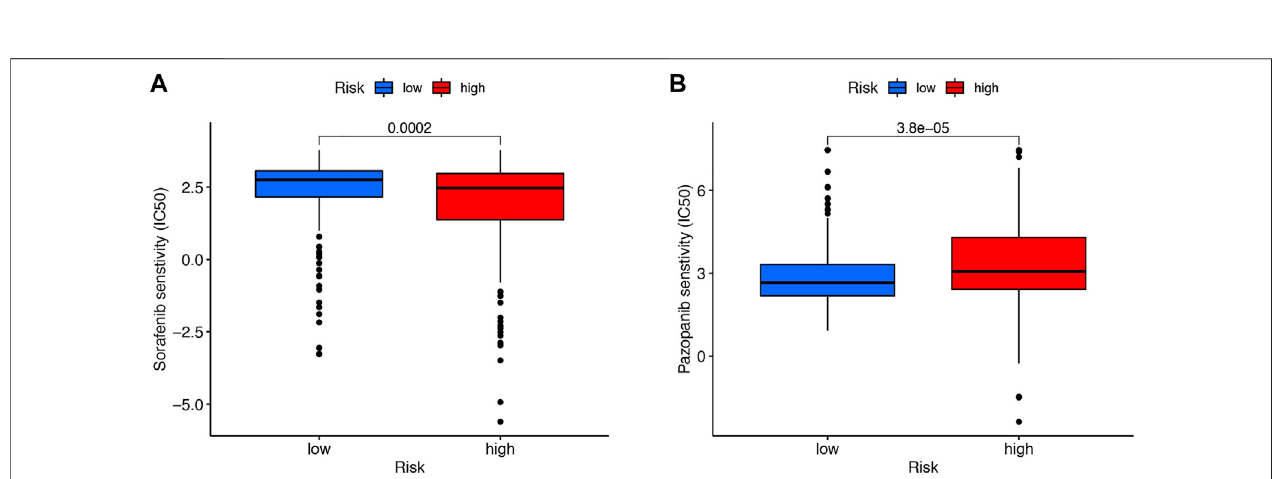
FIGURE 10 | Drug sensitivity. Sorafenib was more effective in the high-risk group (A) . Pazopanib was more effective in the low-risk group (B) .